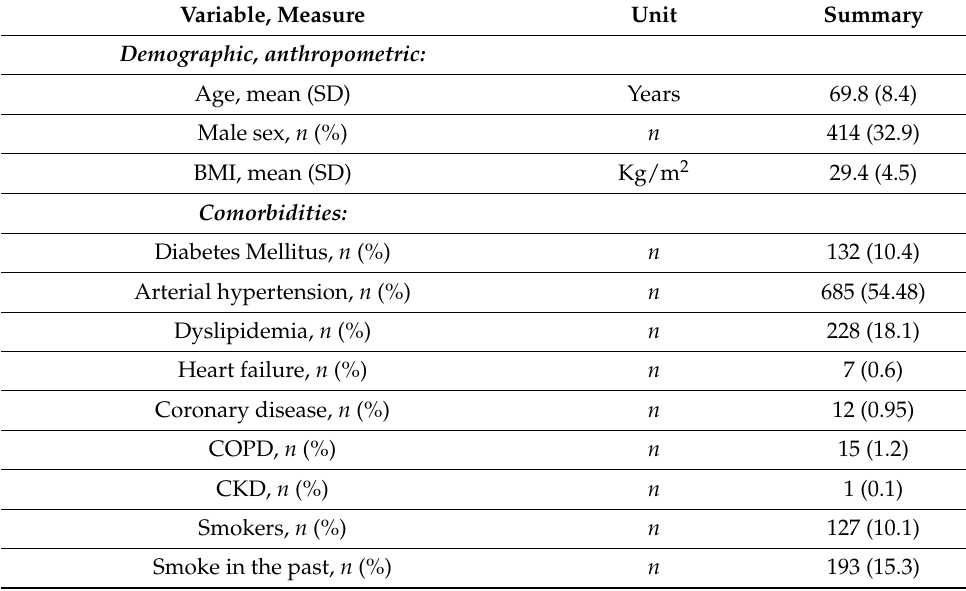
Table 1. Preoperative Charlson’s Comorbidity Index and ASA score are shown in Table 2. Table 1. Descriptive statistics of study